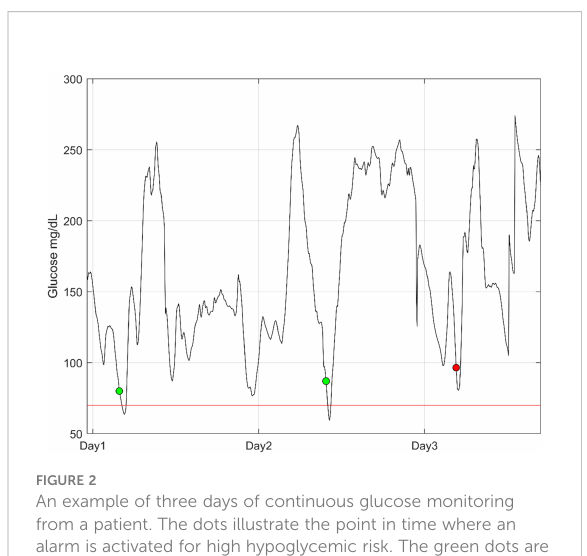
FIGURE 2 An example of three days of continuous glucose monitoring from a patient. The dots illustrate the point in time where an alarm is activated for high hypoglycemic risk. The green dots are true positives, and the red dot is a false alarm. The red line is the threshold for hypoglycemia (70